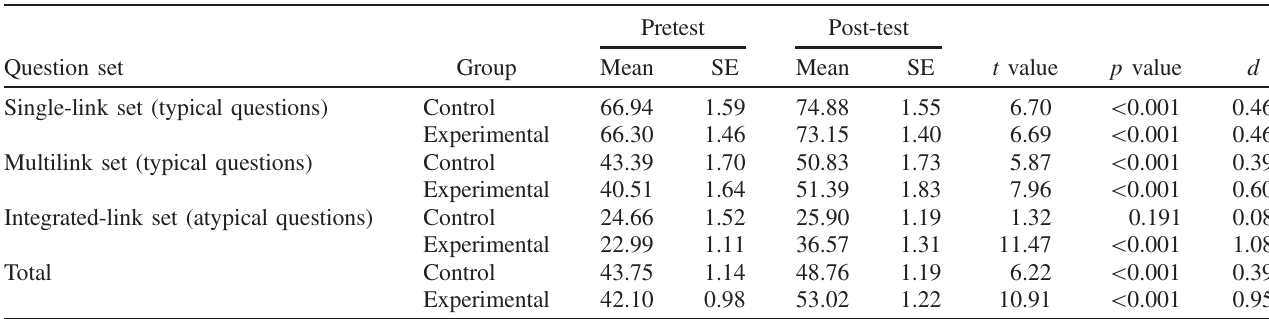
TABLE IV. Summary of students ’ pre- and post-test